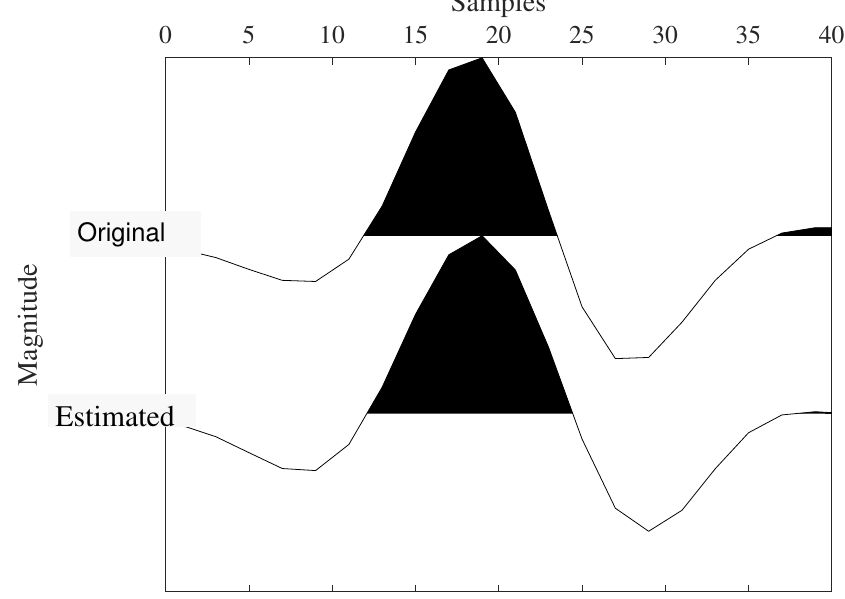
Figure 7. Recovered and true